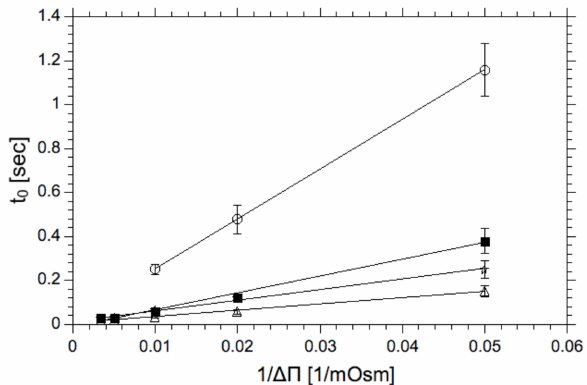
Figure 3. The dependence of the parameter t 0 (as defined on Figure 1) on the osmotic pres- sure difference for membranes formed from various mixtures of lipids; ( 70/30 mol%, ( (cid:52) )—egg-PC/lysoPC 70/30 mol% and ( (cid:79) )—egg-PC/PE 70/30 mol%. T = 25 ◦